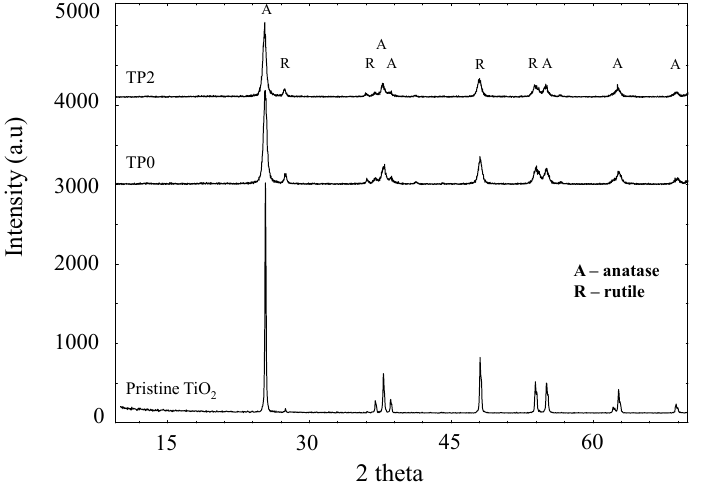
Figure 2. XRD patterns of pristine TiO 2 , TP0 and TP2 samples.